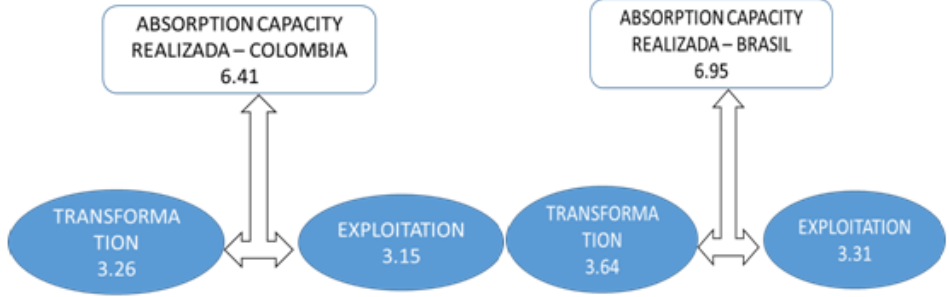
Figure 5. Realized absorptive capacity measurement’s results in Medellín and Minas Gerais’ innovative